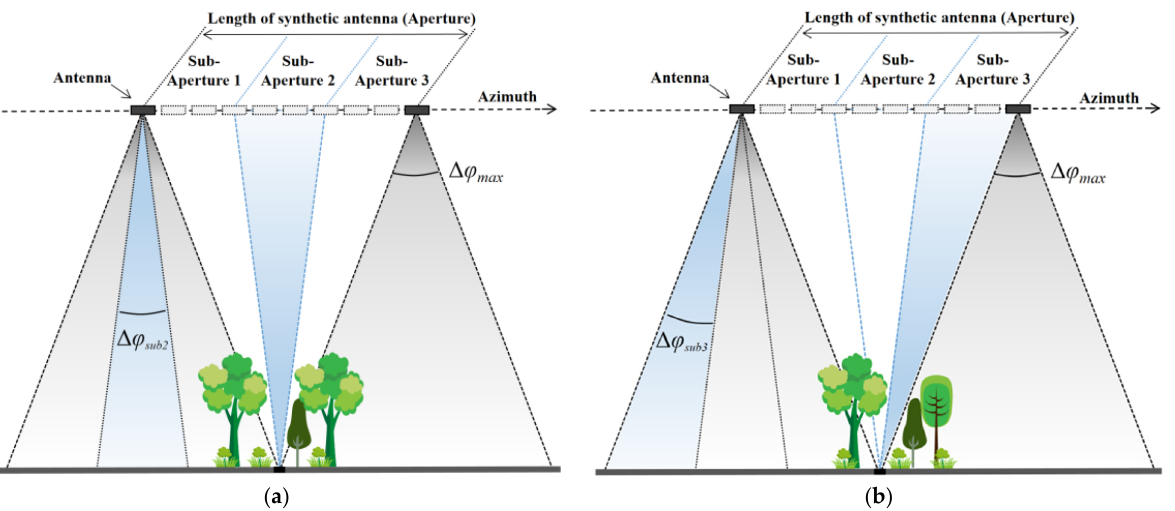
Figure 3. Schematic diagram of the penetration ability of SAR imaging with different subapertures of different forests: ( a ) Subaperture 2 has a better penetration effect on forests; ( b ) Subaperture 3 has a better penetration effect on forests.